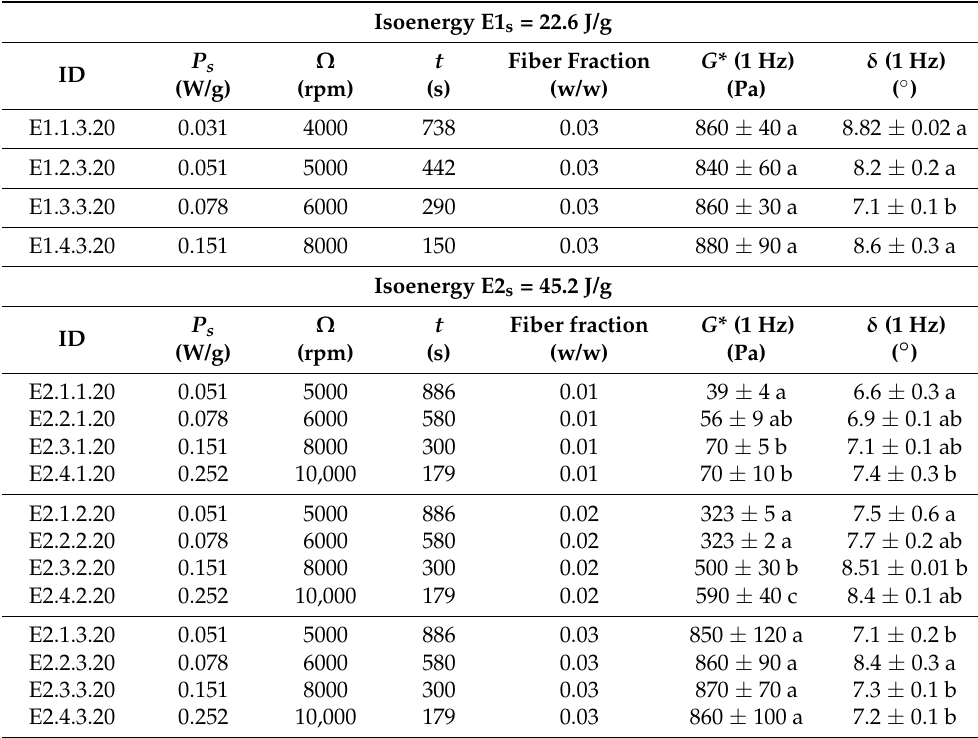
Table 2. Samples prepared at two specific energy levels: E1 s = 22.6 J/g and E2 s = 45.2 J/g. At different speeds ( Ω ), specific powers of mixing ( P s ), mixing times ( t ) and fiber fractions (w/w). G * is the complex modulus and δ is the phase angle. ANOVA was performed on the set of samples having the same fiber concentration. Different letters, for the same parameter and for the set of samples having the same fiber concentration, refer to significantly different